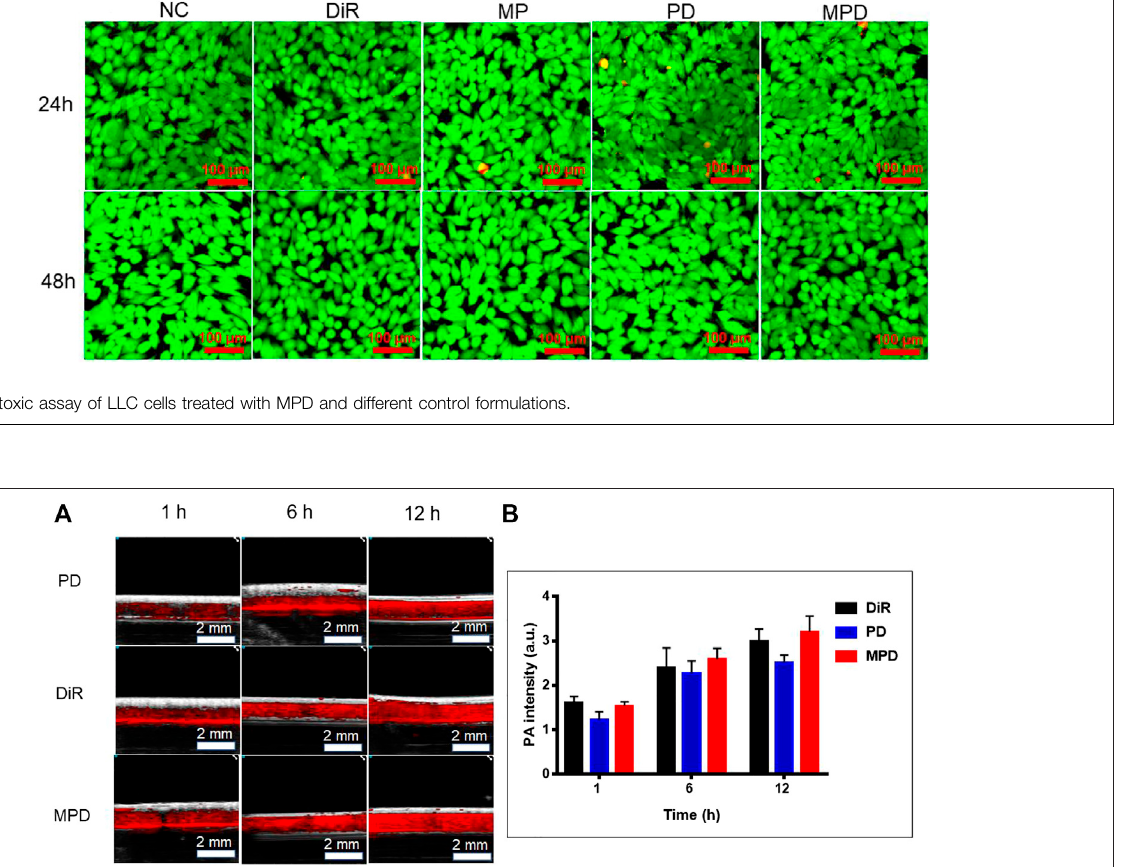
Frontiers in Chemistry |